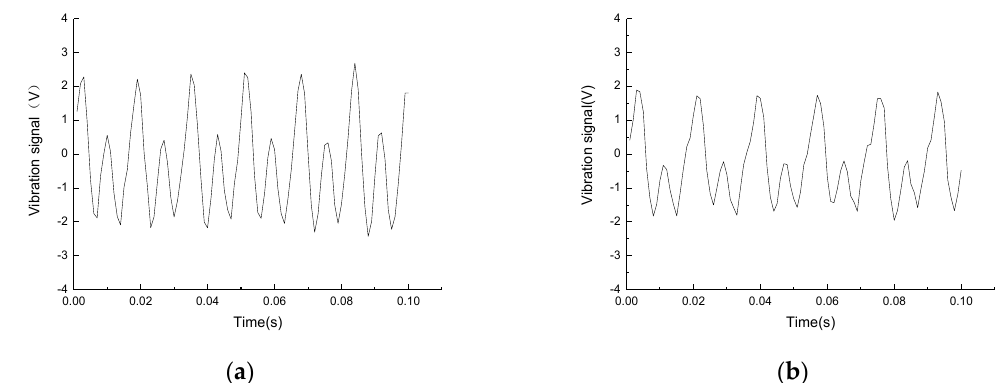
Figure 5. Vibration signal waveform under low oil pressure and normal conditions. ( a ) Vibration waveform in the normal state, ( b ) Vibration waveform when fuel pressure is low.